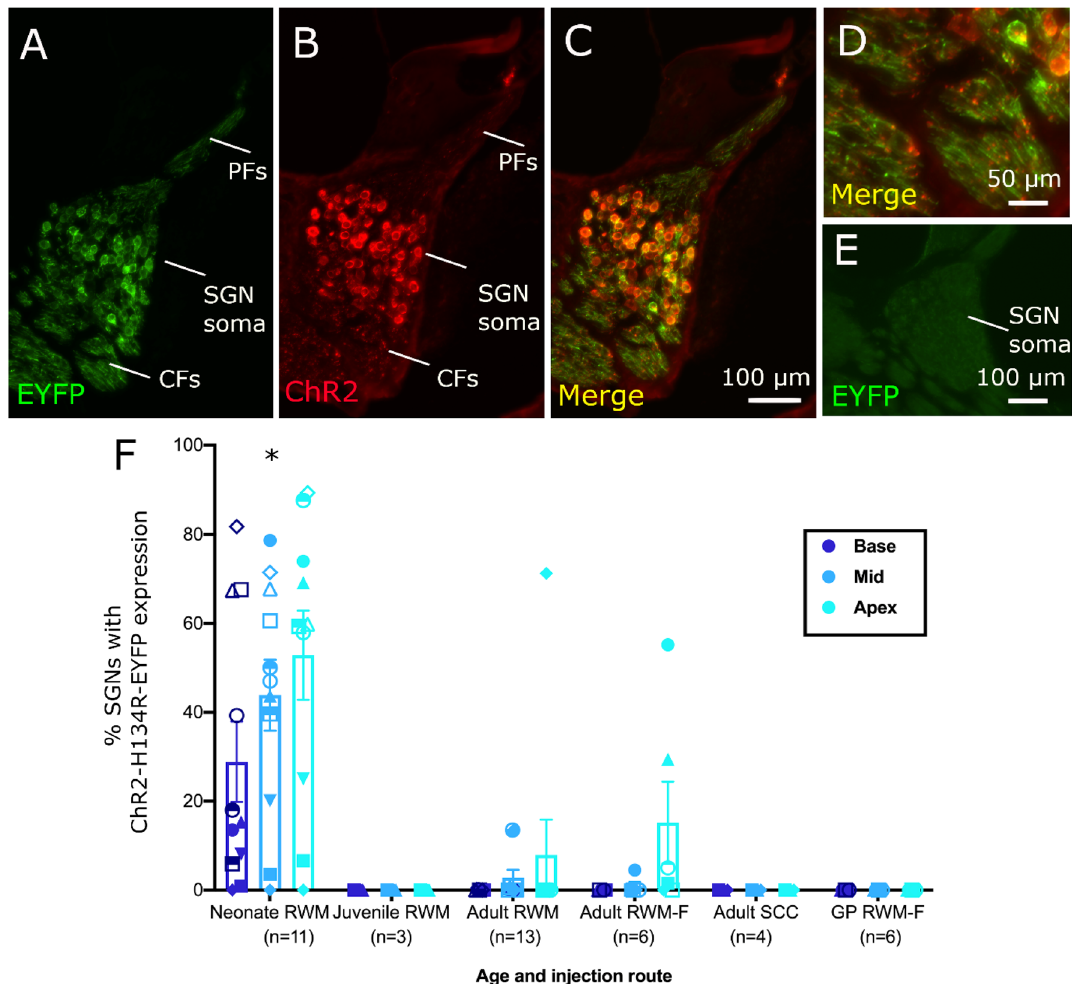
Figure 1. Viral-mediated transduction of SGNs with opsins. ( A ) Expression of EYFP reporter gene in the middle turn of a cochlea from a C57BL/6 mouse injected at a neonatal age. EYFP expression was detected in SGN central fibres (CFs), soma and peripheral fibres (PFs) as far as the synapse with the inner hair cells. ( B ) The same cochlear section labelled with a ChR2 antibody with notably lower expression in PFs and CFs compared to the SGNs ( C ) Merged image of EYFP expression (green) and ChR2 antibody labelling (red). ( D ) Magnified area from central nerve showing punctate ChR2 antibody labelling. ( E ) Cochlear section from an Anc80- injected mouse that had no detectable EYFP expression. ( F ) The overall percentage of ChR2-H134R-EYFP transduced SGNs in C57BL/6 mice or guinea pigs (final category) injected via different routes and at different ages. The neonatalC57BL/6 mouse injection group had the highest percentage of transduced SGNs (*p < 0.05 compared to all other groups, Kruskal–Wallis) and the highest proportion of successful transductions overall (Error bars show the standard error of the mean). Scale bar in C applies to images A-C. (SGN = spiral ganglion neuron, EYFP = yellow fluorescent protein; ChR2 = channelrhodopsin-2; RWM = round window membrane; F = fenestration of semi-circular canals; SCC = semi-circular canals; GP = guinea pig). Minor image processing (brightness) was applied equally to the EYFP channel across images for representation